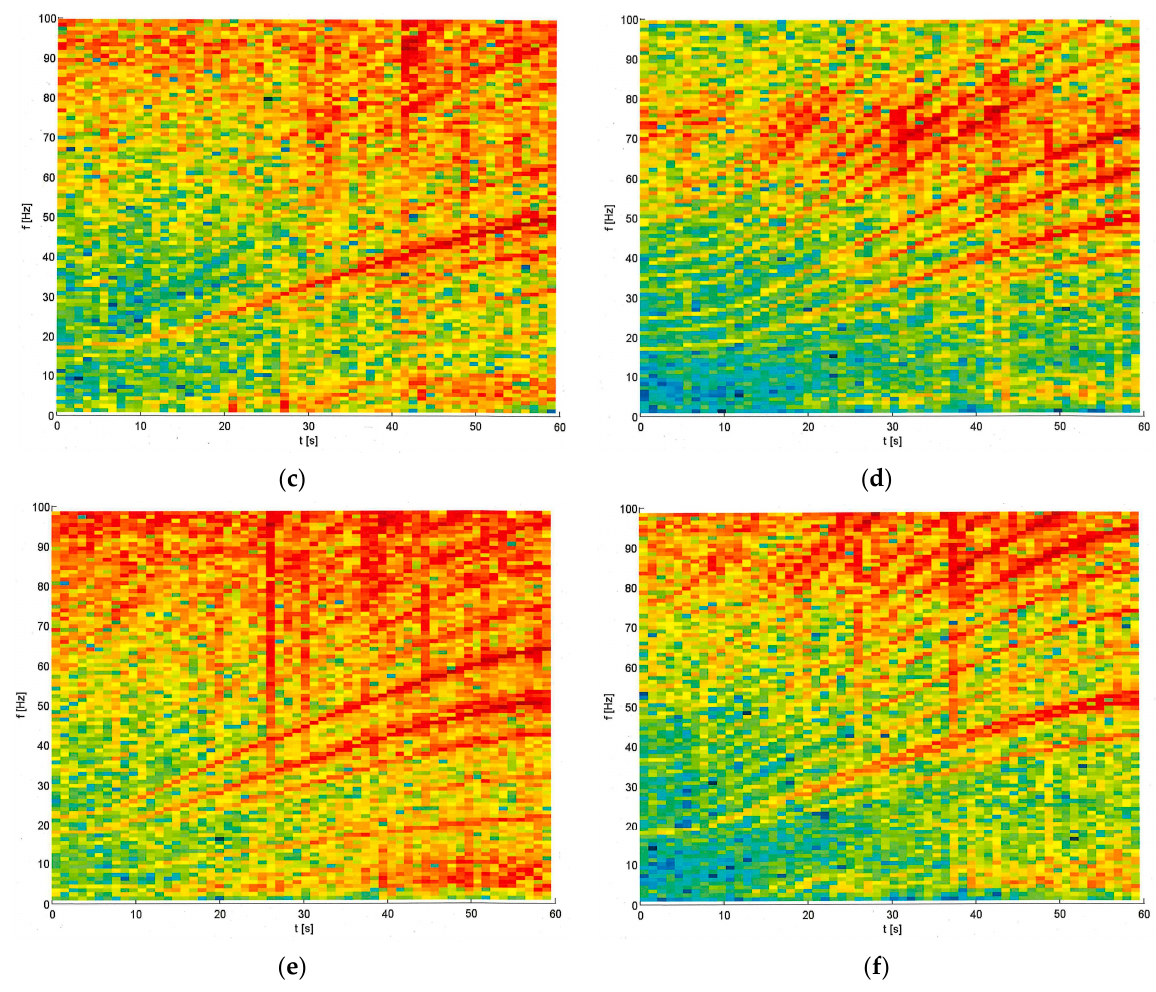
Figure A1. Acceleration run from 40 to 120 km/h, spectrograms of ( a ) the car body C2, ( b ) the bogie B2, ( c ) the wheel A1, ( d ) wheel A2, ( e ) wheel A3, ( f ) wheel A4.